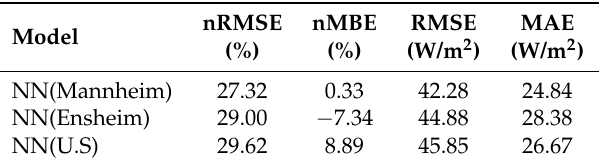
Table 11. Performance of all the three neural network models from both studies on the unseen dataset of Weinbiet (2017 data). Model